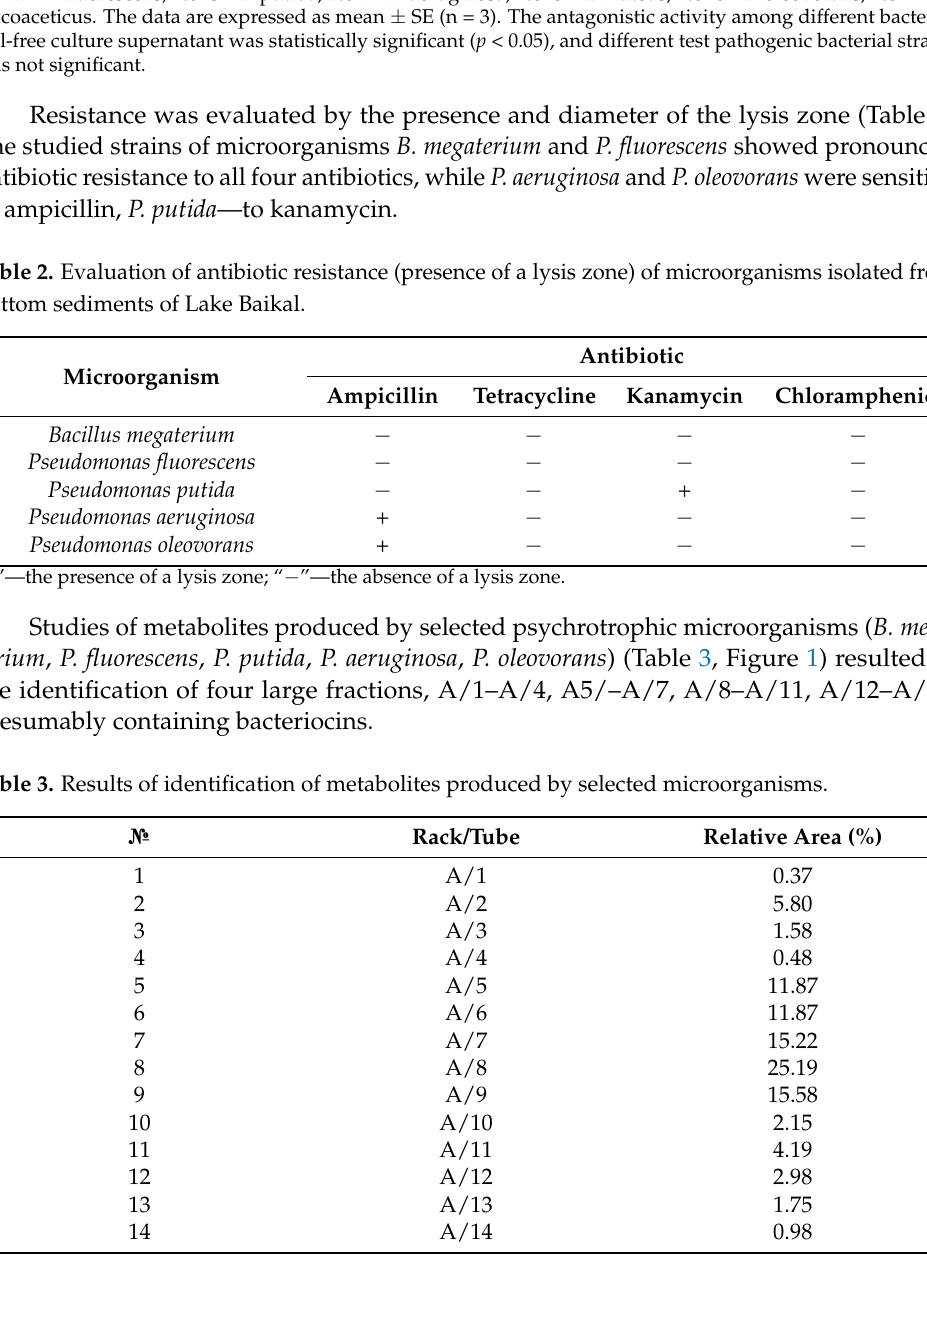
Table 2. Evaluation of antibiotic resistance (presence of a lysis zone) of microorganisms isolated from bottom sediments of Lake Baikal.